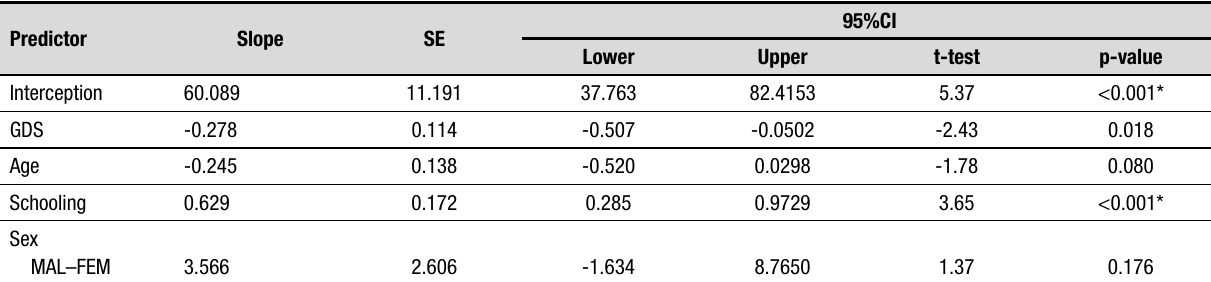
Table 5. Multiple linear regression model.